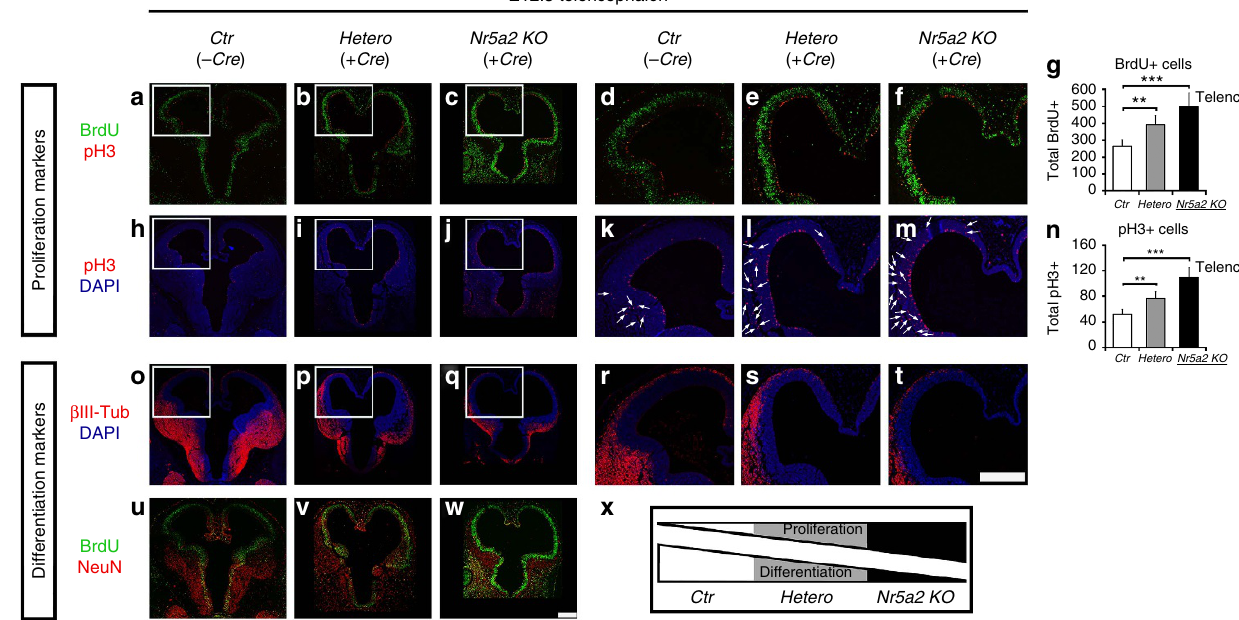
Figure 5 | Cre/LoxP-mediated temporal deletion of NR5A2 affects telencephalon development. ( a – w ) Phenotypic analysis of Hetero (center panels) and Nr5a2 KO (right panels) experimental E12.5 telencephalons, compared with Ctr (left panels), in relation to various proliferation ( a – n ) or differentiation ( o – w ) markers: immunofluorescence images of representative sections depicting the double BrdU þ (green)/pH3 þ (red) ( a – f ), pH3 þ ( h – m ), b III- Tubulin þ ( o – t ) and BrdU þ (green)/NeuN þ (red) ( u – w ) cells. d – f , k – m , r – t micrographs are larger magnifications of the square shapes depicted in a – c , h – j , o – q , respectively. Quantifications of BrdU þ and pH3 þ cells are shown in g and n , respectively (total BrdU þ or pH3 þ /telencephalon section). Arrows in representative pictures ( k – m ) indicate the ectopic pH3 þ -proliferating cells that are localized outside the VZ. ( x ) Schematic representation of the effects of NR5A2 deletion on proliferation and differentiation markers in the telencephalon of E12.5 mouse embryos. All values represent the mean ± s.d. of four animals ( n ¼ 4). * *P o 0.01, ** *P o 0.001 (Student’s t -test). Scale bars, 250 m